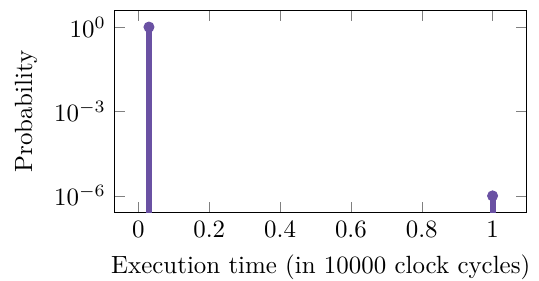
Figure 2 Execution-time distribution on example sequence with random